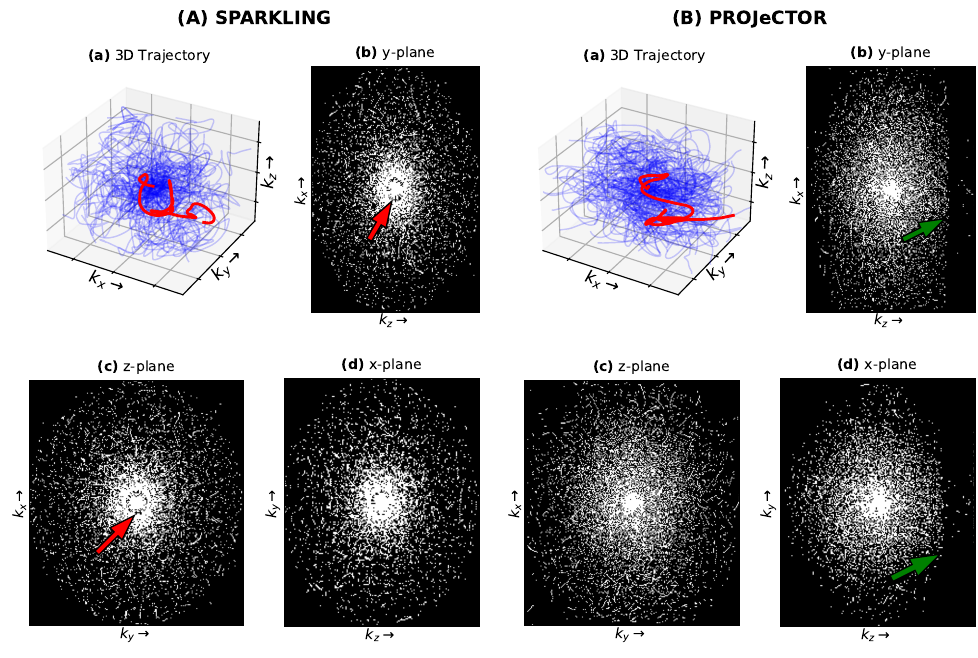
Figure 7. k -space sampling trajectories for ( A ) SPARKLING and ( B ) PROJeCTOR. For easier visual- ization, only 70 shots of 3D trajectory are shown in ( a ). The resulting gridded sampling pattern is shown for mid-plane slices along the ( b ) y-plane, ( c ) z-plane and ( d )